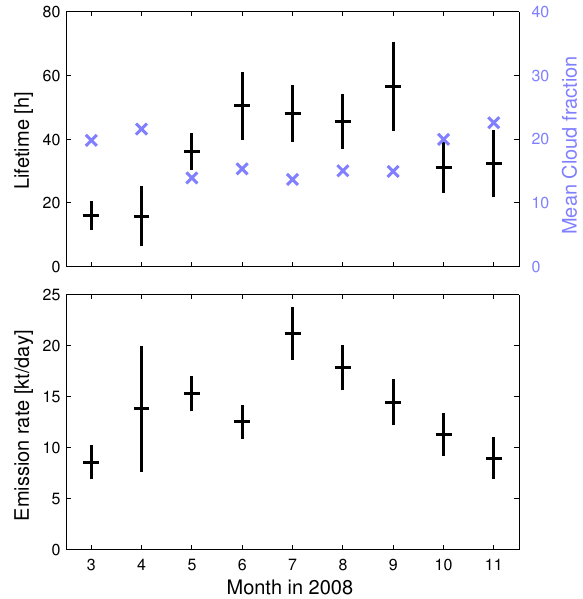
Figure 5. Fitted monthly mean SO 2 lifetimes τ (top) and emission rates E (bottom) for March–November 2008. Error bars indicate the confidence intervals derived from the least-squares fit. In the upper panel, the monthly mean cloud fraction (from GOME-2) is also included, revealing an anticorrelation to τ ( R = − 0 .